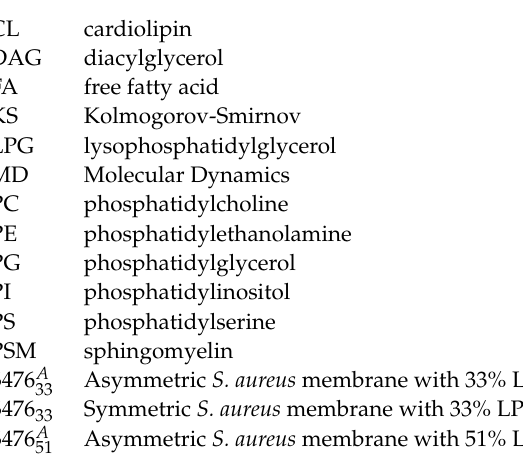
Figure S4: Distance Filter Selection for Rat Liver Plasma Membrane; Figure S5: Savitsky-Golay Filter Selection; Figure S6: Langmuir Isotherms; Figure S7: Effect of S476 A Size on Spectra after Normalization; Figure S8: Clustering Analysis for KS Statistics of S 476 33 and S 476 A Replicas; Figure S9: KS Statistics for S476 33 and S476 A 33 Equilibration; Table S1: Asymmetric S. aureus Membrane Compositions per Leaflet; Table S2: Detailed Membrane Compositions; Table S3: Complete KS Statistics; TCL Script Dipole